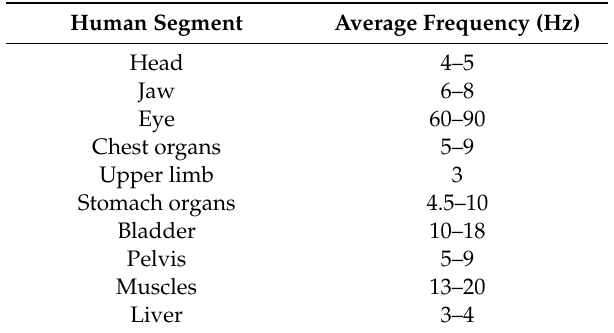
Table 2. Frequencies of human organs and parts (Cempel,